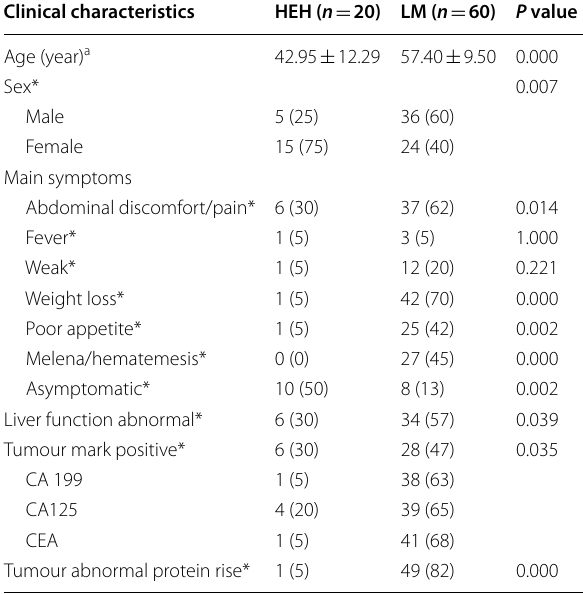
HEH hepatic epithelioid haemangioendothelioma, LM liver metastases * Data are number of patients with the percentage in parenthesis; p values were calculated from χ 2 test and Fisher’ exact test a Data are mean standard deviation; p values were calculated from student t ± test